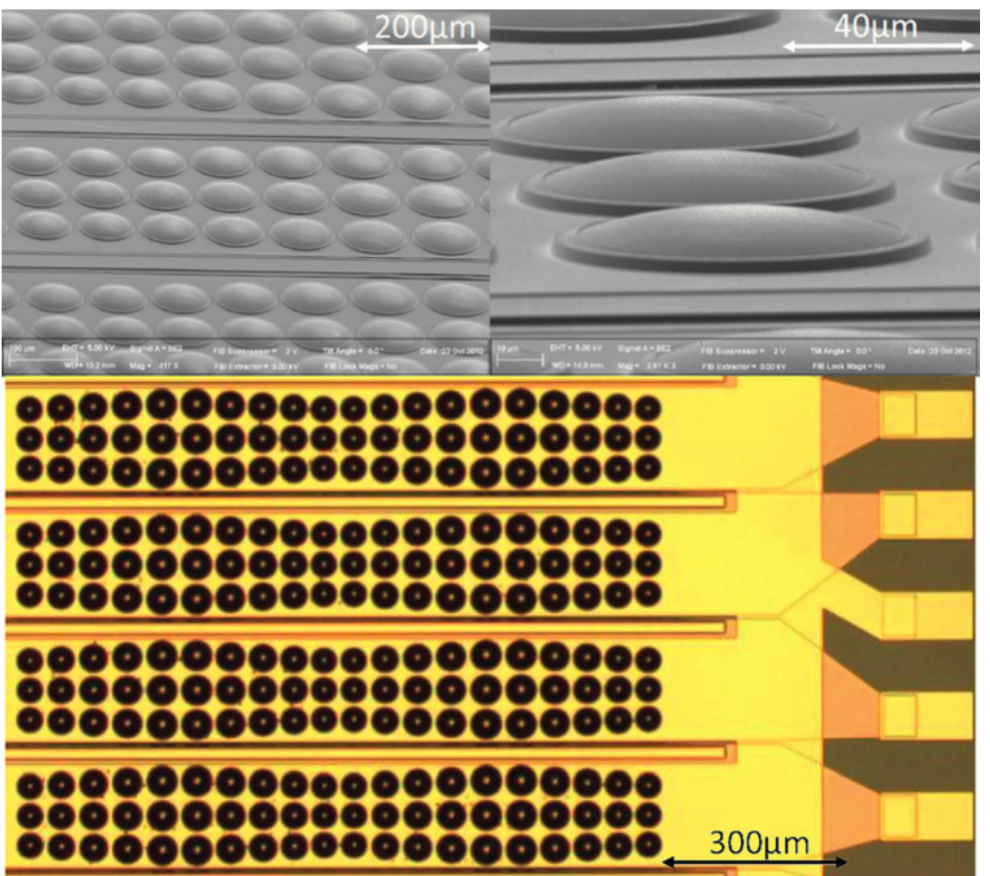
Figure 12. SEM and optical images of a 64 channel 5 MHz linear array exploiting five different dome sizes with cavities ranging from 74 to 90 µm diameter. © 2012 AIP Publishing LLC. Reprinted with permission from